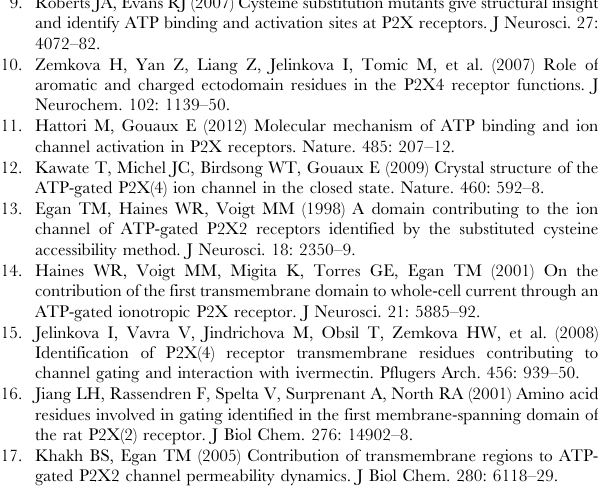
Figure S3 The structure of the ATP binding site in the rP2X4R homology model. (A) The possible interaction of N293 and Y292 residues with Y315 and G316 residues from the b -sheet segment from the K313-I333 sequence. (B) The multiple interactions of residues R203 (yellow spheres) and N204 (green spheres) with partners (all in cyan wireframes) from the same